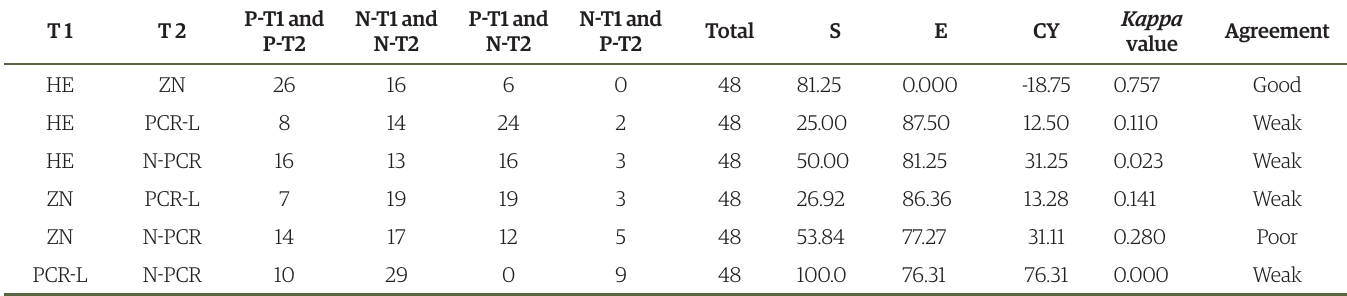
table 1. Results and concordances expressed by the Kappa coefficient between the diagnostic methods HE, ZN, PCR-L and N-PCR, performed from lesions suggestive of bovine tuberculosis, obtained in slaughterhouses, under SIF, during post-mortem